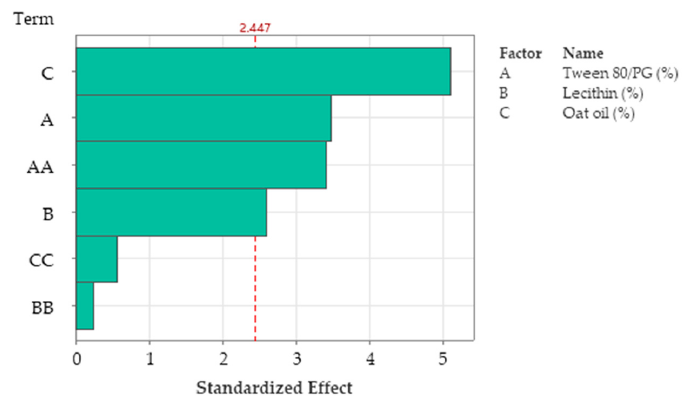
Figure 21. Pareto Chart of standardized effect for W response, emphasizing the main factors